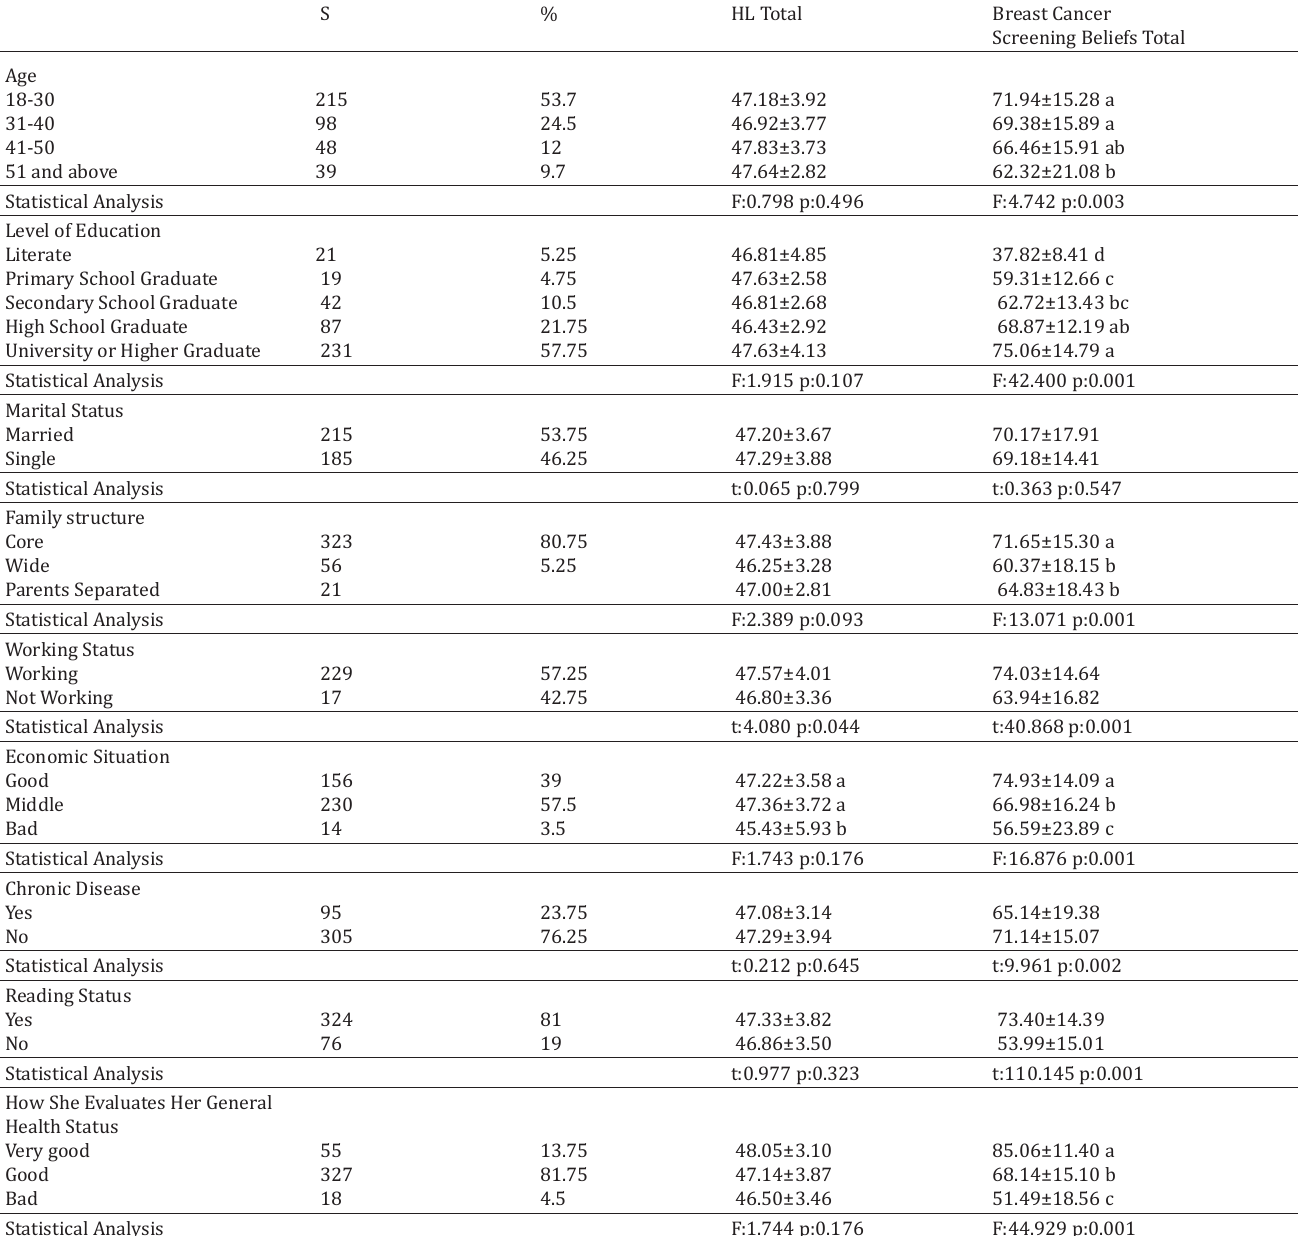
Table 1 Sociodemographic of Women, Reading and Distribution of Characteristics of Health Conditions